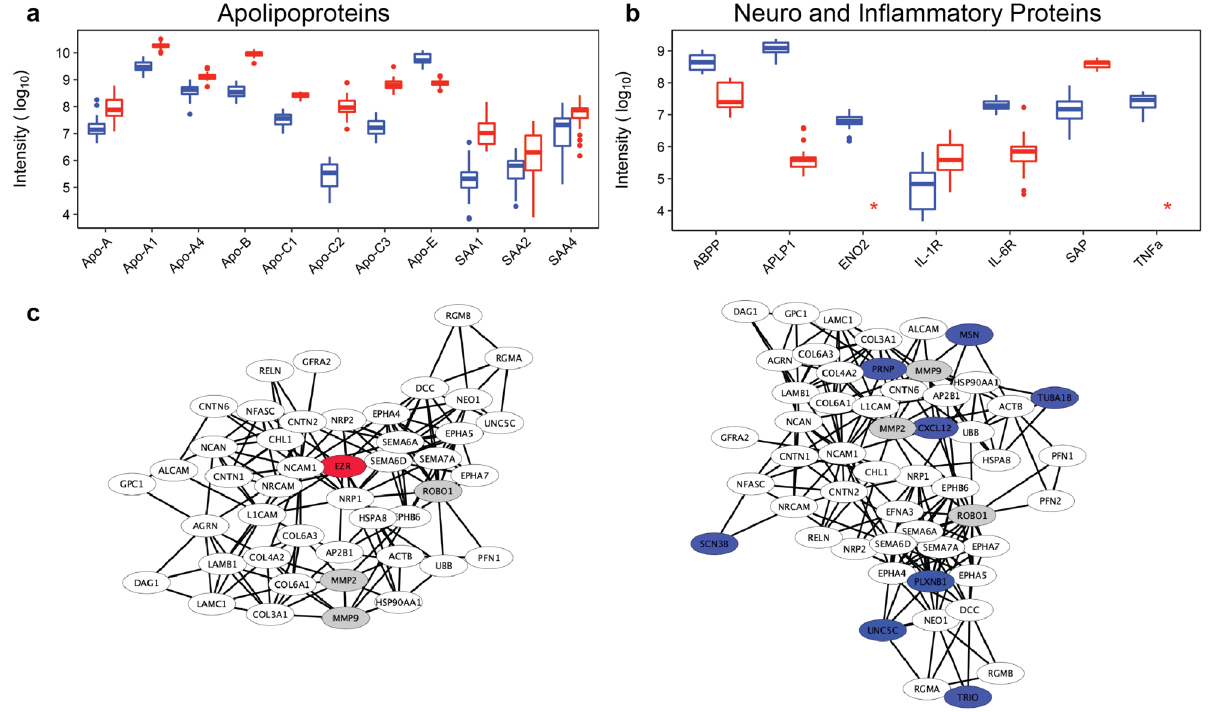
Figure 4. ( a ) Boxplots of apolipoprotein intensity and comparison between CSF (blue) and serum (red). Serum amyloid A proteins (SAA#) and apolipoproteins (Apo-letter). Apolipoproteins are generally more abundant in serum over CSF with the exception of Apo-E. ( b ) Boxplots of important detected neuro and inflammatory proteins serum amyloid-P and P1 (SAP), amyloid precursor protein (ABPP), Interleukins 1 and 6 (IL-1 and IL-6), γ-enolase (ENO2). ( c ) STRING over-representation analysis of axon guidance. Proteins marked in grey control multiple biochemical pathways and were common in our over-representation analysis. Proteins marked in white are common to CSF and serum, proteins marked in blue and unique to CSF, and the protein marked in red is unique to